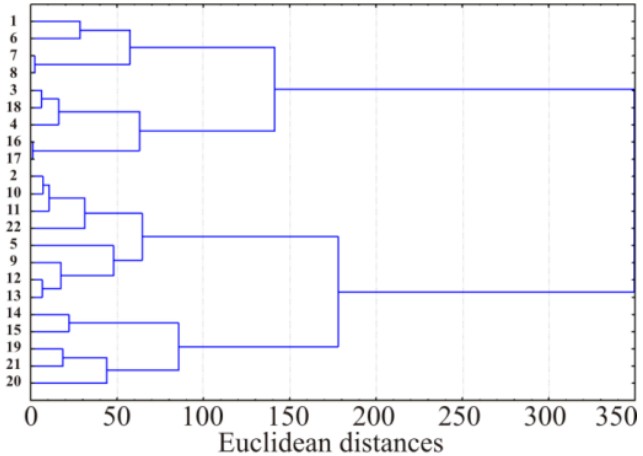
Figure 5. The dendrogram of similarity in relation “salinity — 137 Cs concentration” between samples taken from the studied Crimean lakes (a sample number was given in Table 1).